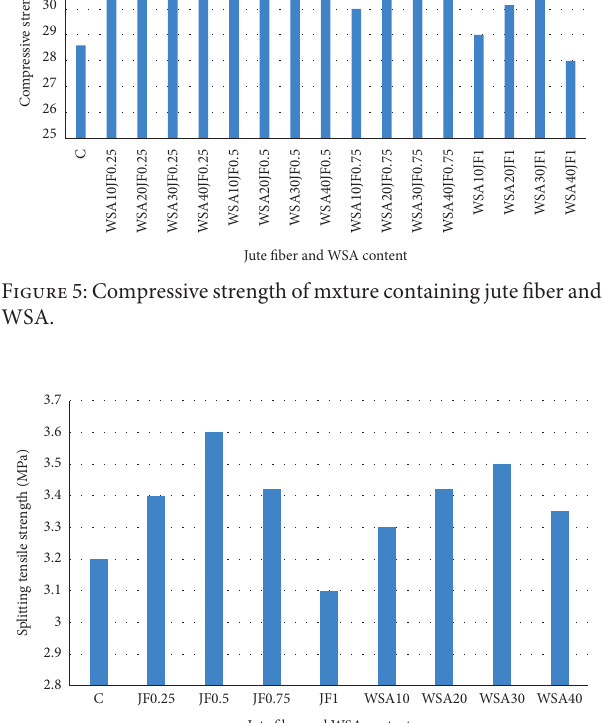
Figure 6: Splitting tensile strength of mixture containing jute fiber and